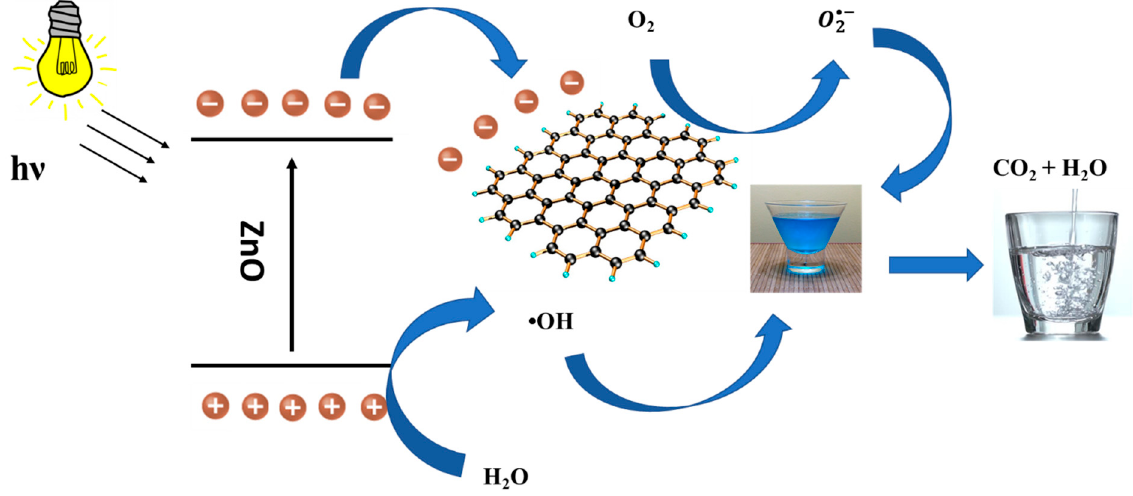
Figure 10. Schematic representation of the photodegradation mechanism.